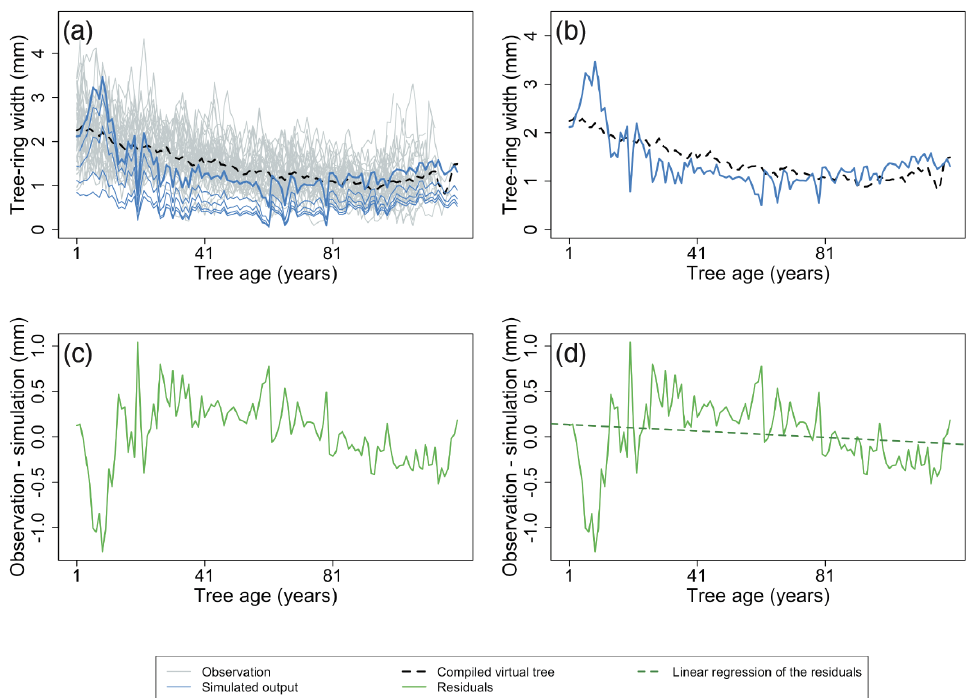
Figure 5. Example of the major steps for calculating the metrics of the benchmark for the size-related trend in diameter increment. The size-related trend in diameter increment can be assessed by calculating a time series for the average ring width after aligning the age of the individual trees (a, b) . Observations are shown as grey lines, and the simulation is shown as blue lines. The largest diameter class from the simulation is presented by the bold line. The black dotted lines represent the virtual tree based on the observations. The TRWs of this virtual tree are then subtracted from the simulated TRWs of the largest diameter class (c) . Subsequently, a linear regression is used to quantify the temporal trend in the residuals (d) . The green line denotes the model residuals, and the green dotted line is the linear regression of the model residuals. Furthermore, the root mean square error (RMSE) between the simulations and observations is calculated ( b ; RMSE between blue line and black dotted line) and normalized by the length of the time series to calculate the difference in observed and simulated growth trends. Observations and the simulation are from a Pinus sylvestris site in Finland, archived as finl052 (Meriläinen et al., 2004). For this example, the calculated RMSE (b) is 0.39mm, and the slope of residuals (d) is − 0.002mmyr − 1